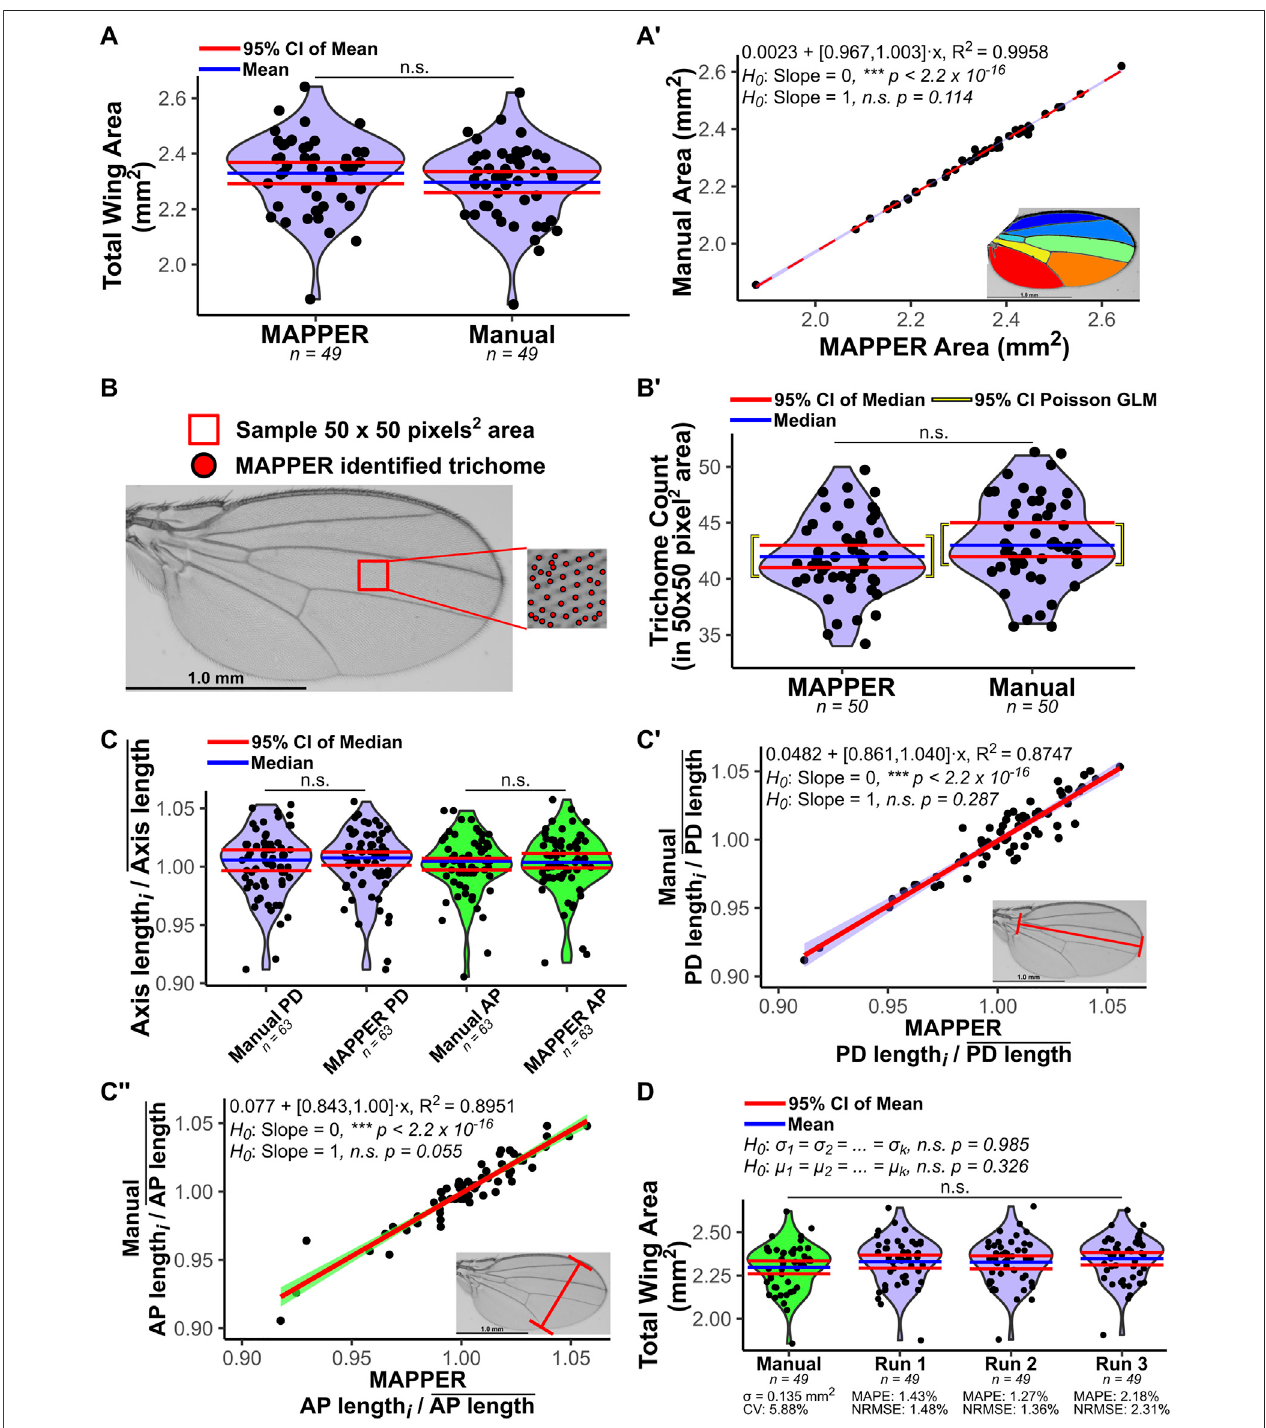
FIGURE 3 | Validation of automated measurements generated by MAPPER. Manual measurements were taken and compared to MAPPER ’ s output. (A) Total wing area measurement distributions of automated and hand measurements are compared. An F-test (Snedecor and Cochran, 1989) compared the variances of the distributions ( p = 0.928), and an unpaired T-test (Fisher, 1925) compared the means ( p = 0.236). (A 9 ) A linear regression fi t of automated versus manual measurements (red dashed line corresponds to the fi t, and light-blue bands correspond to the 95% CI of the fi t). The slope parameter of the fi t was not statistically different from